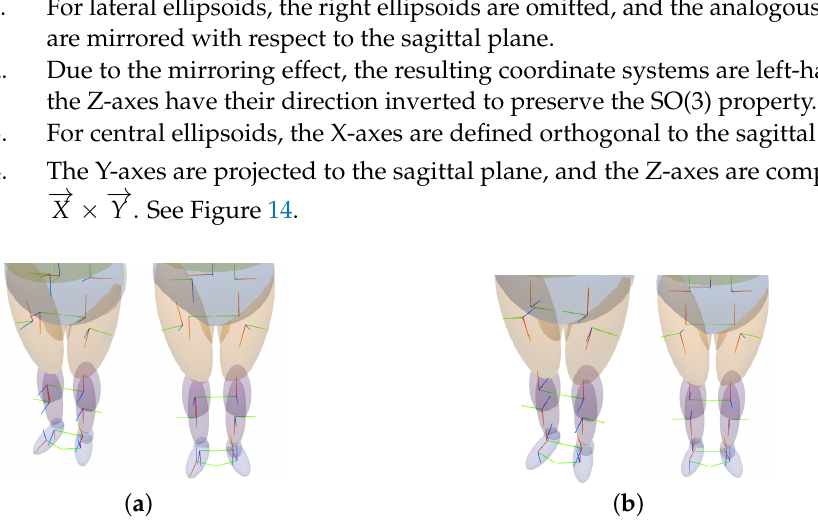
Figure 13. Correction of lateral ellipsoid symmetry of ellipsoids from Tall Chubby with only legs displayed for the example. ( a ) Asymmetric model. ( b ) Symmetric